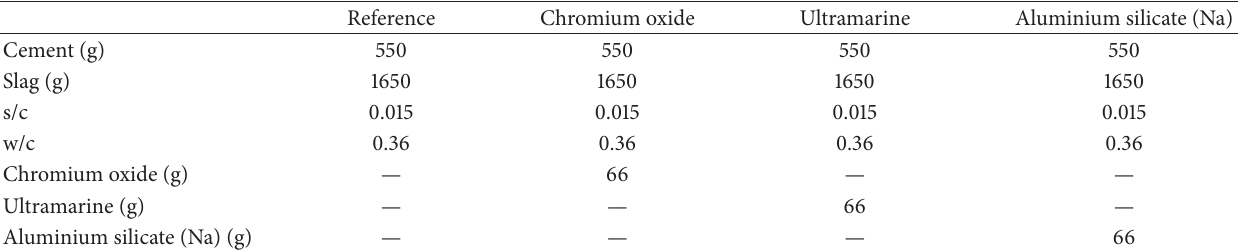
Table 1: Mortars mix proportions and samples symbolic names.